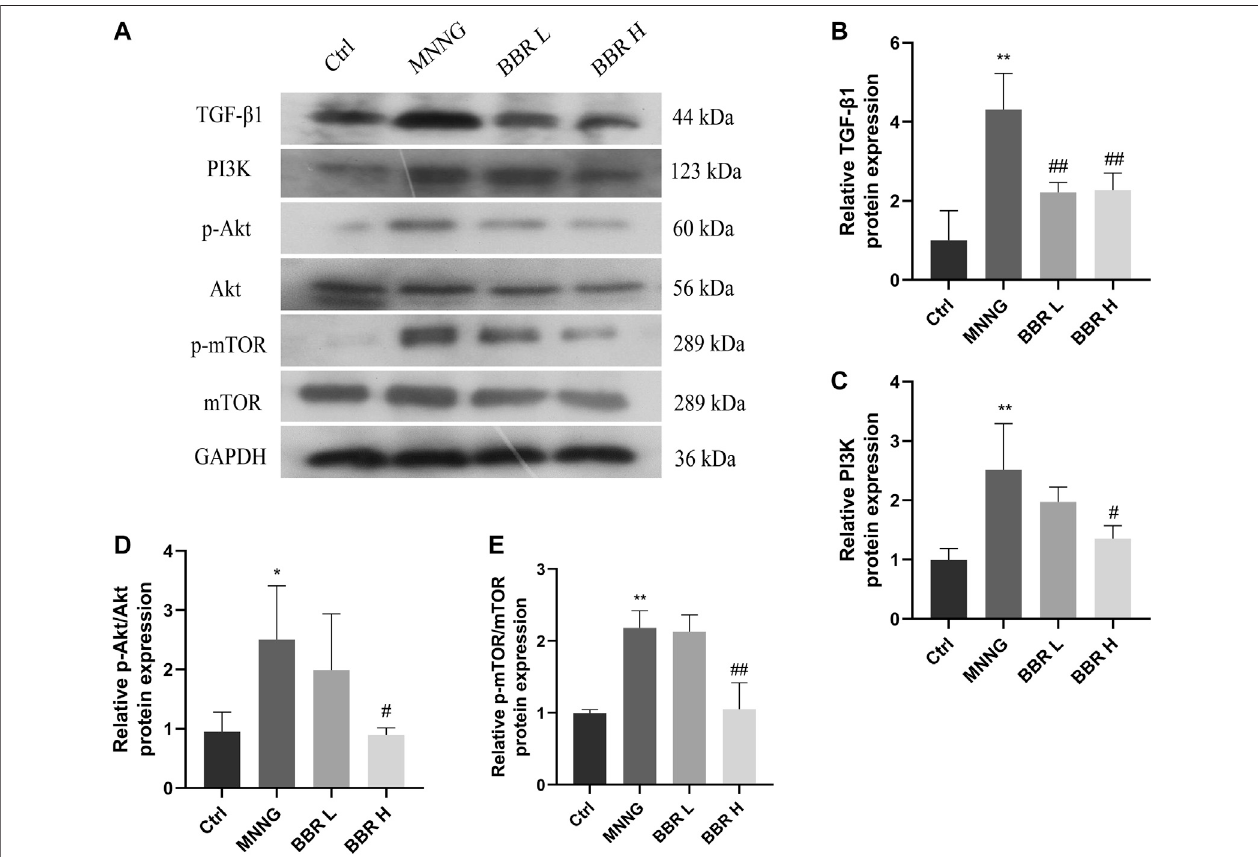
FIGURE 8 | Effect of BBR on proteins expression in CAG rats (A) Western blotting images of TGF- β 1, PI3K, p-Akt, Akt, p-mTOR, mTOR (B) Relative TGF- β 1 protein level in stomach (C) Relative PI3K protein level in stomach (D) Relative p-Akt/Akt protein level in stomach (E) Relative p-mTOR/mTOR protein level in stomach. Data were shown as mean ± SD ( N (cid:1) 3). ** < 0.01 vs. control group; * < 0.05 vs. control group. ## < 0.01 vs. MNNG group; # < 0.05 vs. MNNG group. Ctrl, Control; BBR L, BBR low dose group; BBR H, BBR high dose